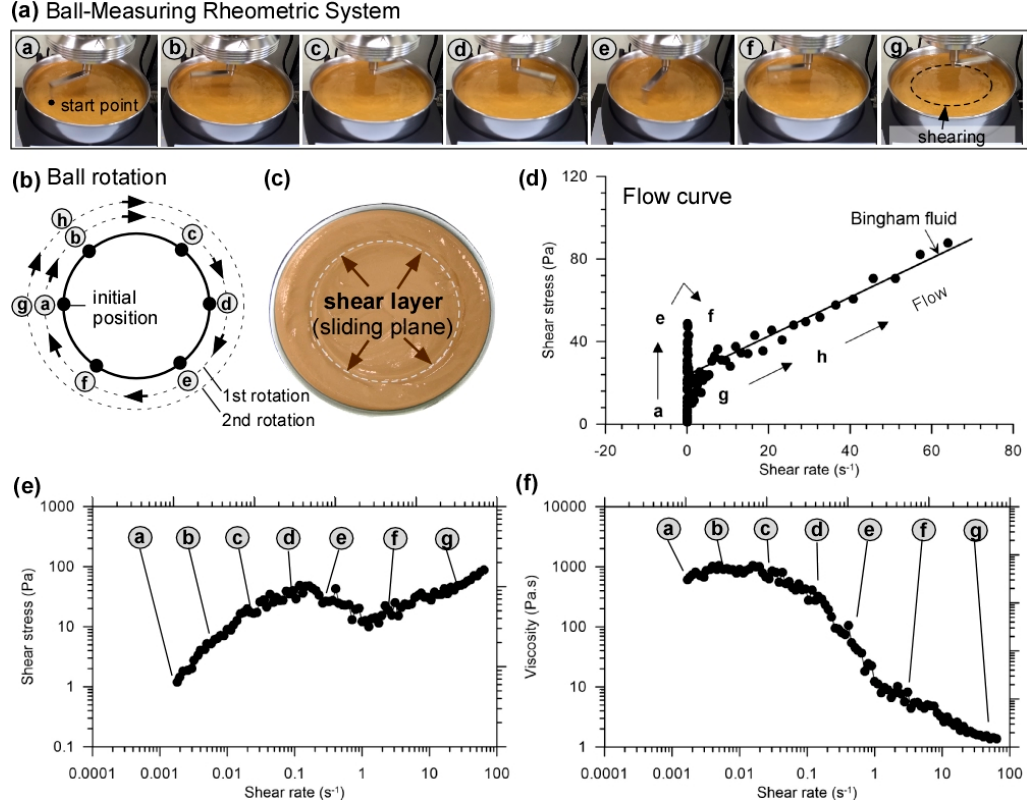
Figure 1. Ball-measuring rheometric system: ( a ) Test procedure, ( b ) schematic view of ball rotation, ( c ) shear layer formation (sliding plane in a steady-state condition) during shearing, ( d ) flow curve with Bingham fluid and ball rotation, ( e ) shear stress–shear rate plot, and ( f ) viscosity–shear rate plot. Tested from ⓐ to ⓖ.